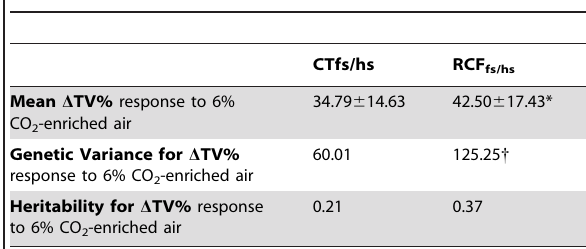
Table 1. Tidal Volume percent increment ( D TV%) in response to 6% CO 2 in RCF and normally-reared (CT) pups at postnatal day 16–20: Mean Values, Genetic Variance, and Heritability figures estimated from unrelated, half-sib and full-sib individuals.